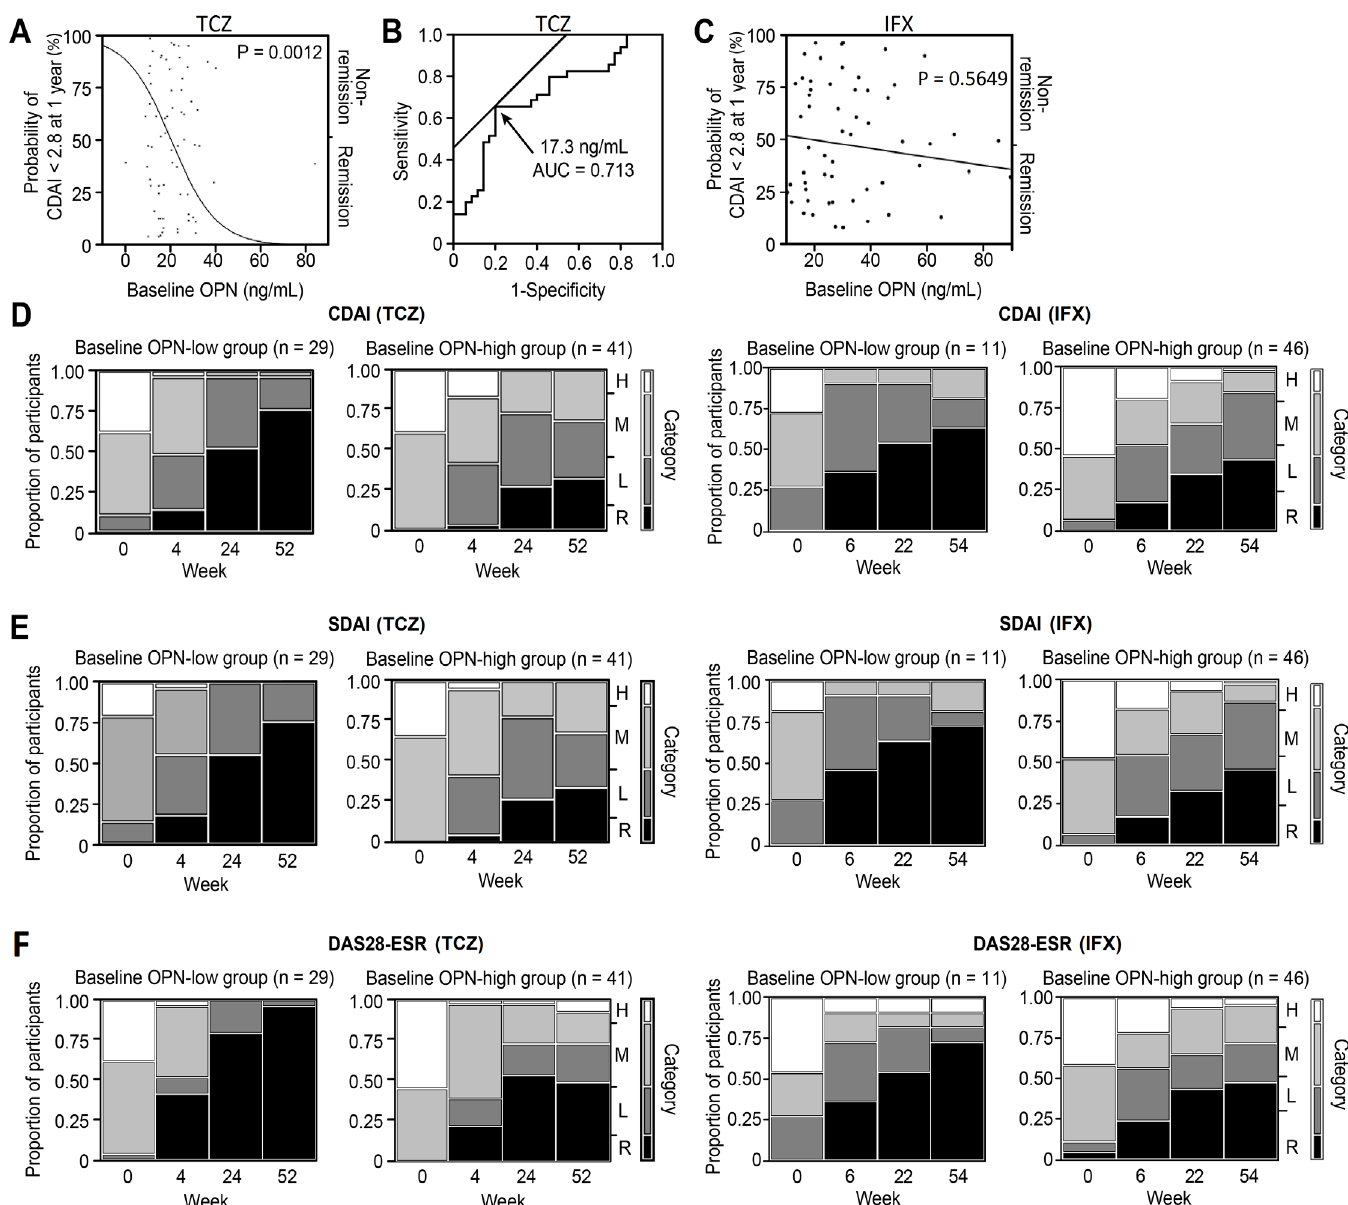
Fig 2. Predictive ability of osteopontin for clinical remission in patients with RA who received tocilizumab (TCZ) or infliximab (IFX). (A) Logistic regression analysis showing significant association of increasing baseline osteopontin (OPN) levels with decreasing predicted probability of achieving Clinical Disease Activity Index (CDAI) remission at 1 year in the TCZ (tocilizumab) group. (B) ROC curve showing a cut-off baseline OPN level of 17.3 ng/mL, discriminating between CDAI remission and non-remission at 1 year in the TCZ group, with a sensitivity of 66% and a specificity of 80%. (C) Logistic regression analysis showing no significant association of baseline OPN levels with predicted probability of achieving CDAI remission at 1 year in the IFX (infliximab) group. Categorical changes in clinical indices such as (D) CDAI, (E) Simplified Disease Activity Index (SDAI), and (F) disease activity score with 28 joint counts, erythrocyte sedimentation rate (DAS28-ESR) over 1-year treatment of TCZ or IFX, stratified by low or high baseline OPN levels (cut-off: 17.3 ng/mL). H, high disease activity; M, moderate disease activity; L, low disease activity; R,